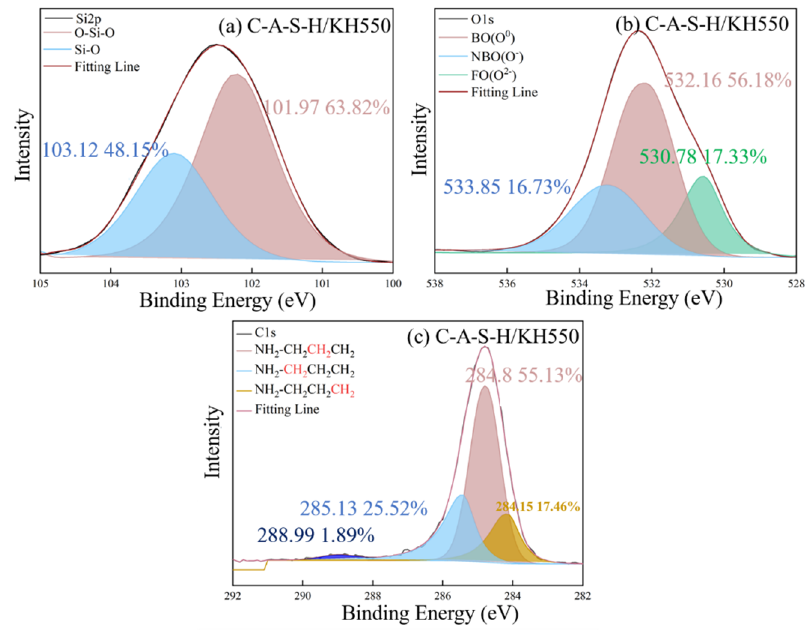
Figure 13. The XPS deconvolution spectrum of ( a ) Si 2p, ( b ) O1s XPS, ( c ) Ca 2p/3 of C ‐ A ‐ S ‐ H/KH550.